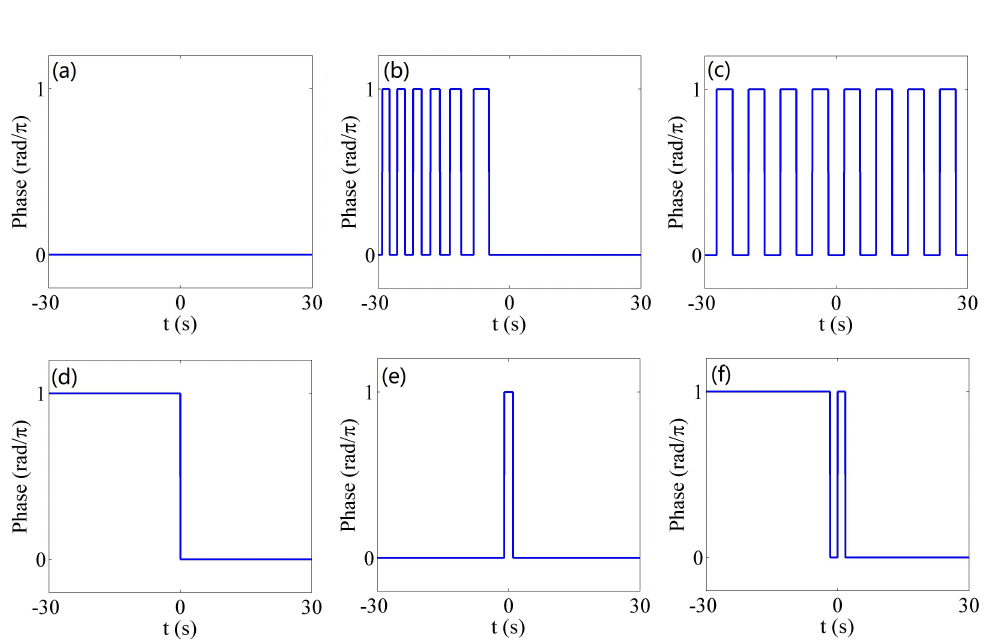
polymial and t 0 = 2.5